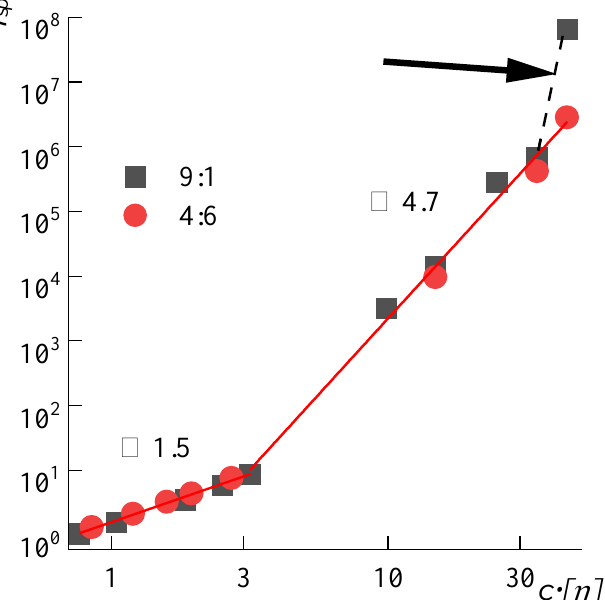
Figure 3. Dependences of the reduced viscosity on the c [ η ] parameter for ABPBI solutions in the DMSO:MeOH:KOH complex solvent with DMSO:MeOH ratios are 9:1 and 4:6, KOH is 100 wt% of the polymer at 25 °C. The arrow shows the deviation from the linear dependence caused by the solution gelation.